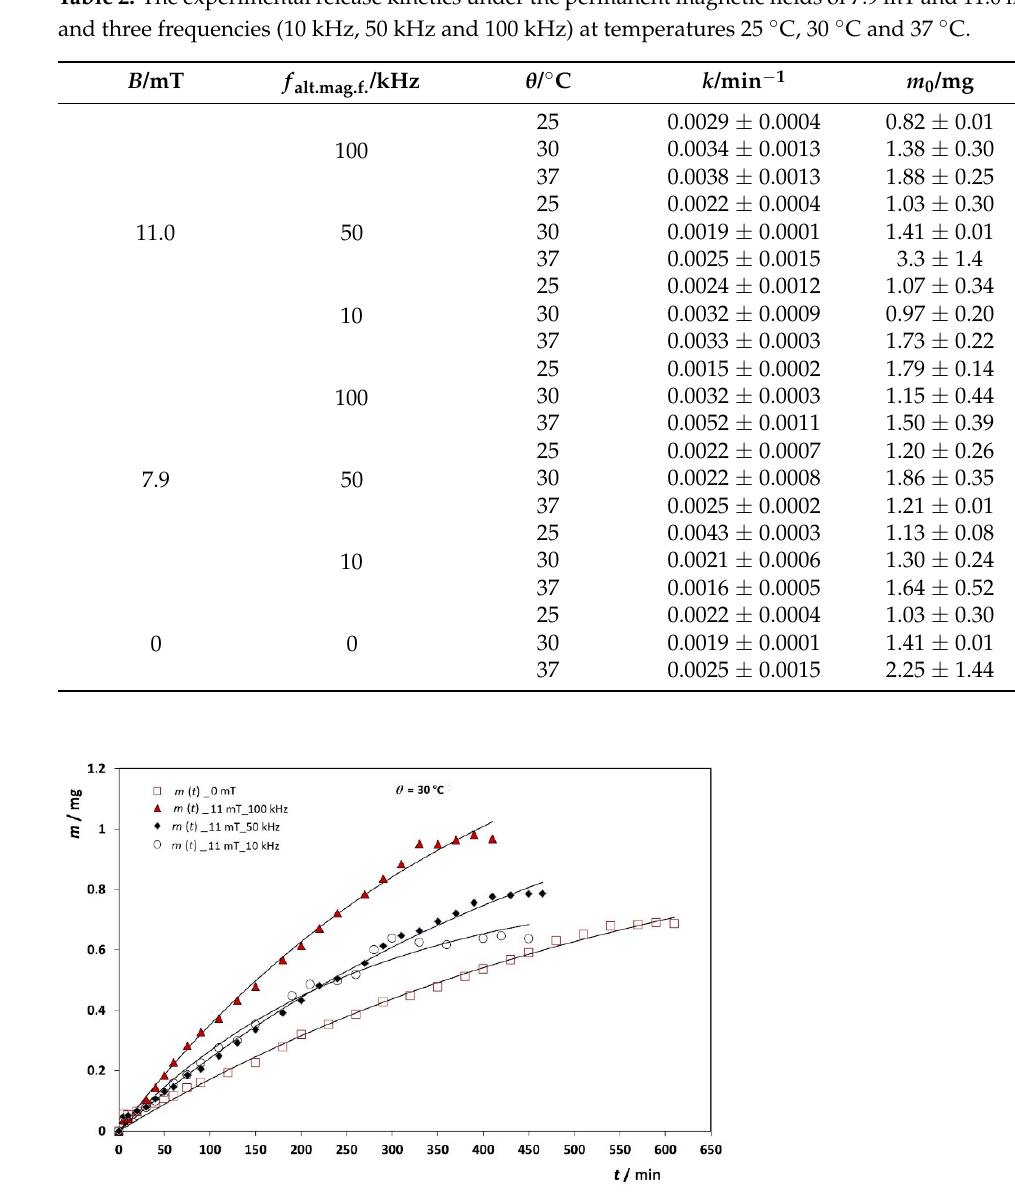
Figure 8. The representative cumulative release profiles for the quercetin from MNPs through dialysis membrane under the stationary magnetic field B = 11 mT and alternating field with frequencies 10 kHz, 50 kHz and 100 kHz at 30 °C.